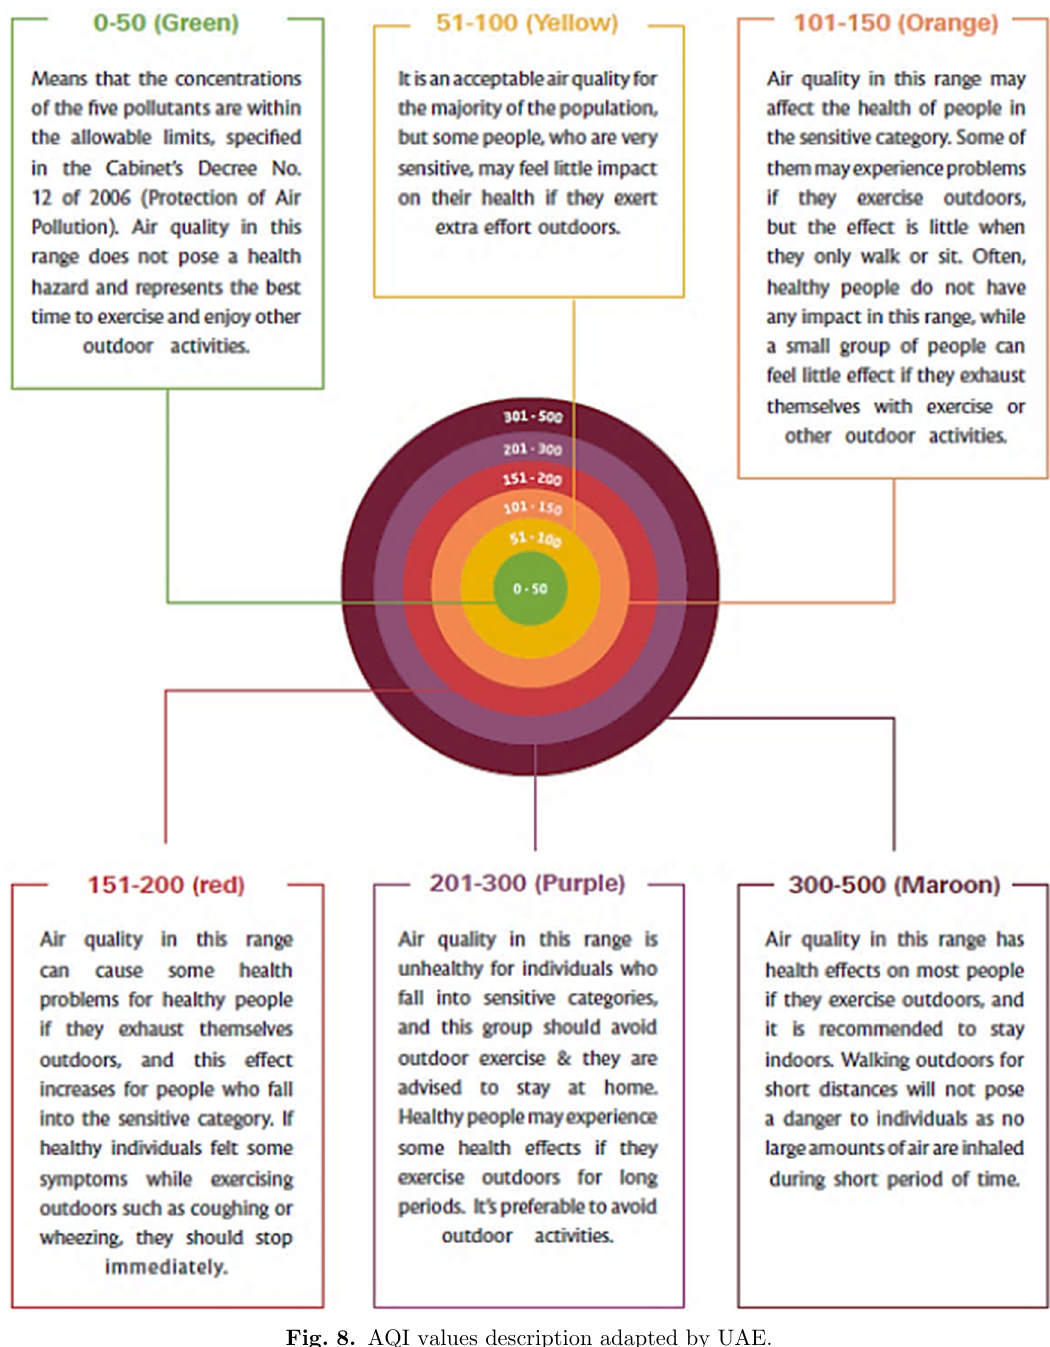
Fig. 8. AQI values description adapted by